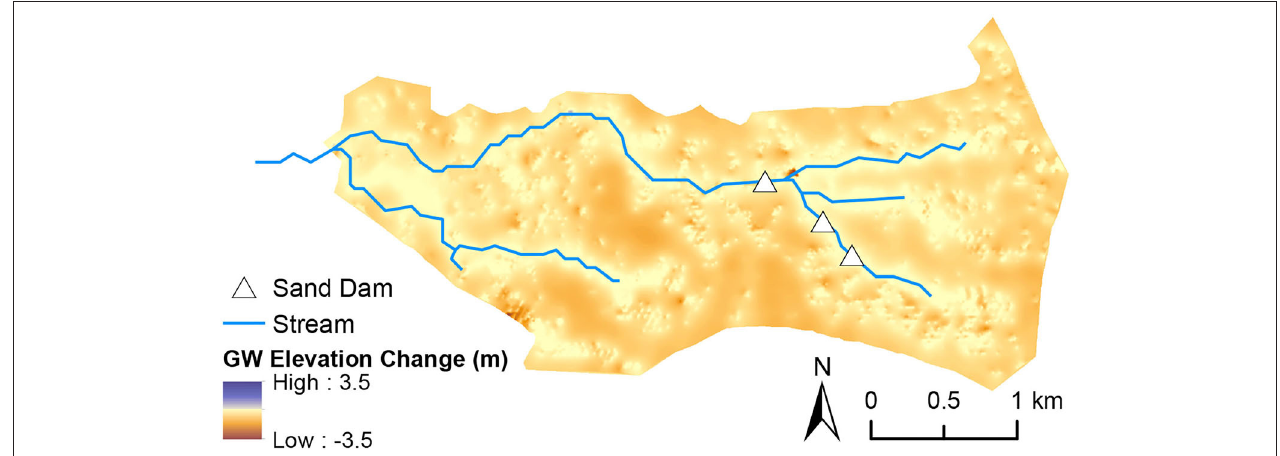
FIGURE 12 | The difference between S1 and S5 groundwater (GW) elevation change at the end of the simulation period for the Chididimo watershed. A positive value indicates S1 produced a greater increase in GW elevation relative to